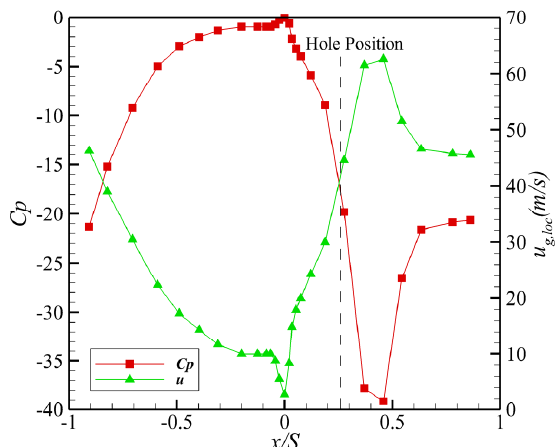
Figure 7. Dependence of pressure coefficient and local velocity on position in the middle section of the vane. the